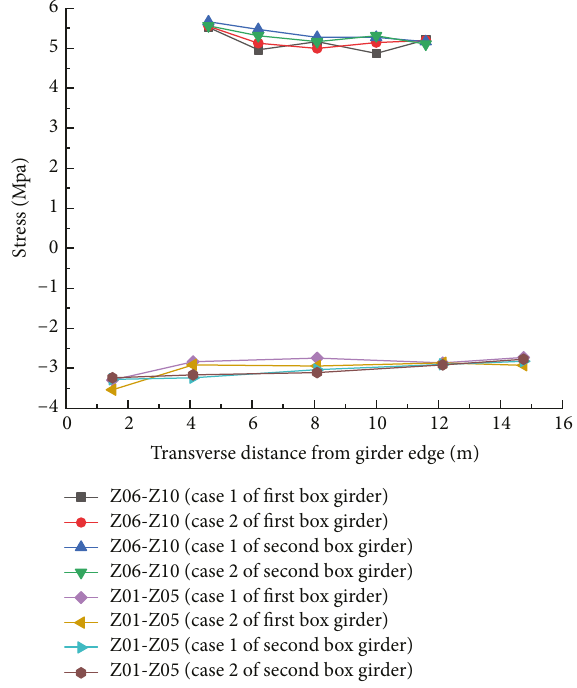
Figure 13: Stress increment comparison of Case 1 and Case 2.